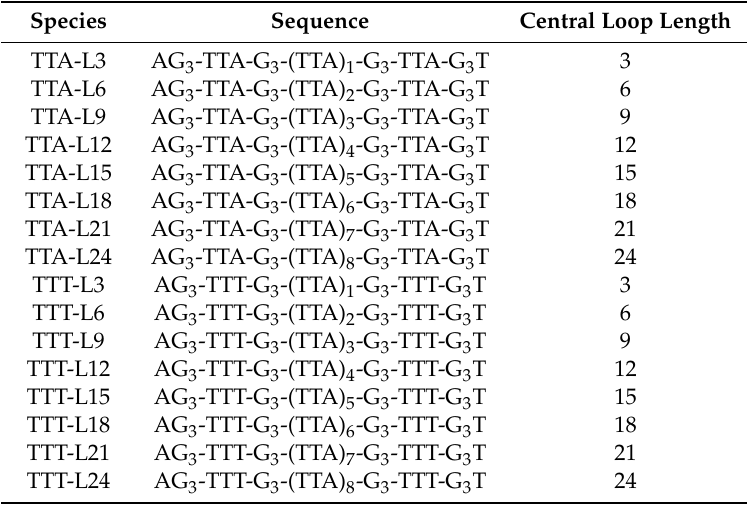
Table 3. Two series of oligonucleotides used in this